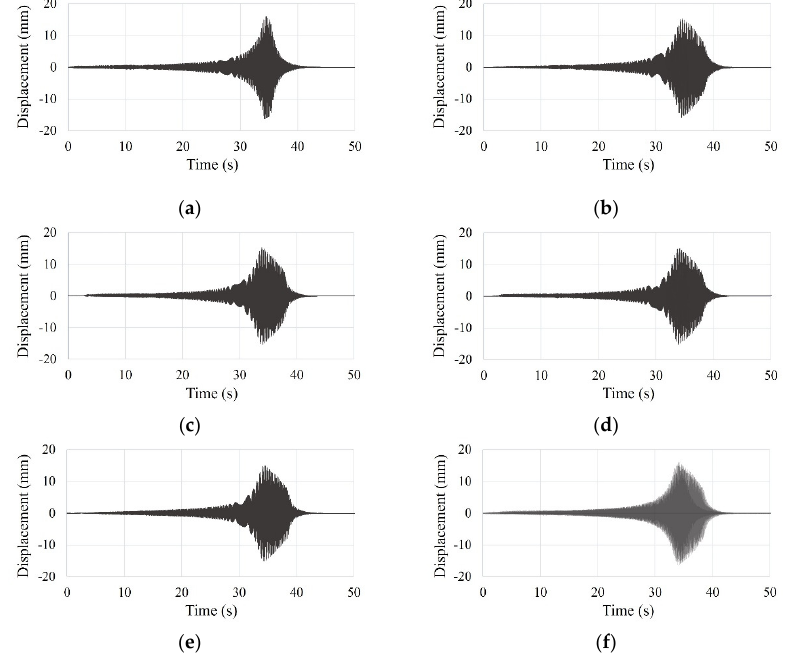
Figure 10. Time history curve of the SDOF model by sinusoidal forced vibration test: ( a ) first test; ( b ) second test; ( c ) third test; ( d ) fourth test; ( e ) five test; ( f ) overlapping entire